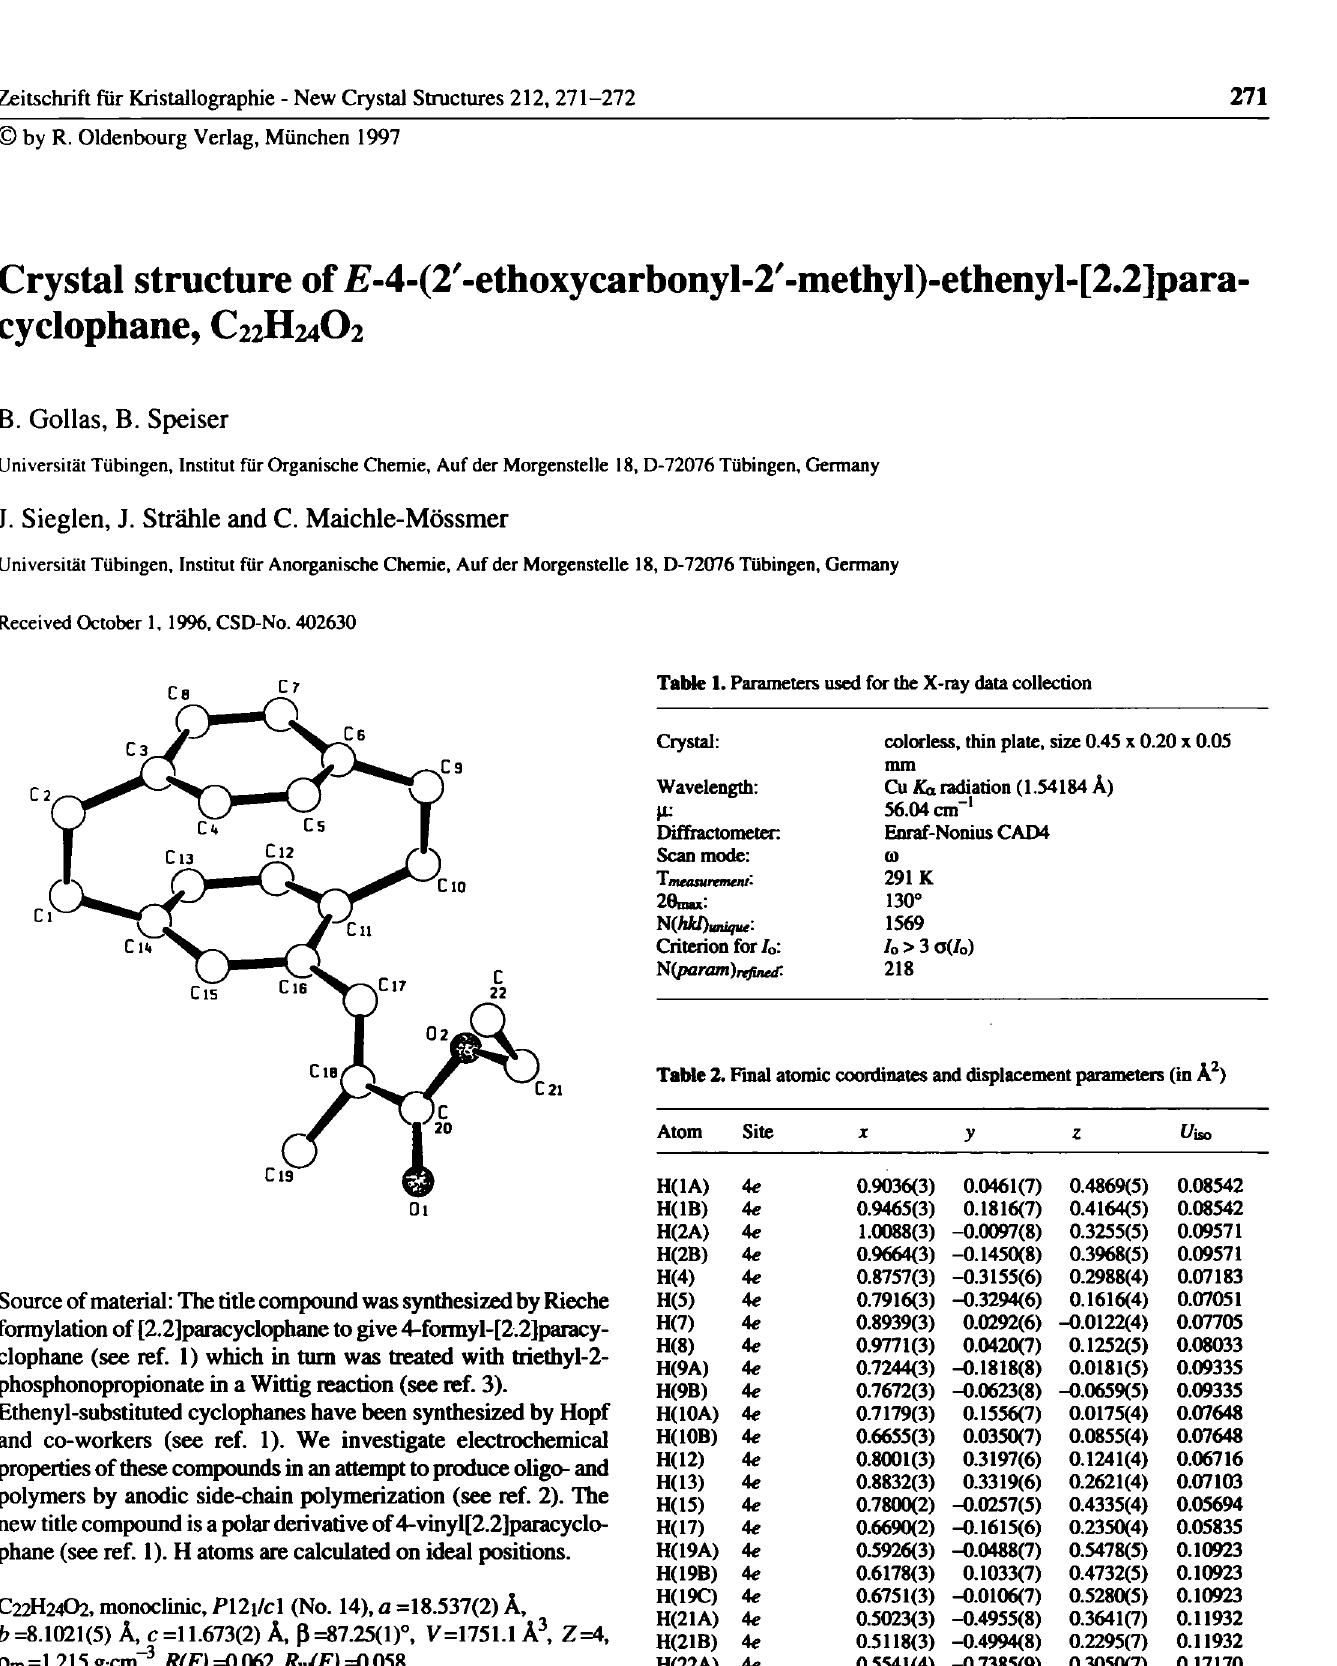
Table 3. Final atomic coordinates and displacement parameters (in Â 2